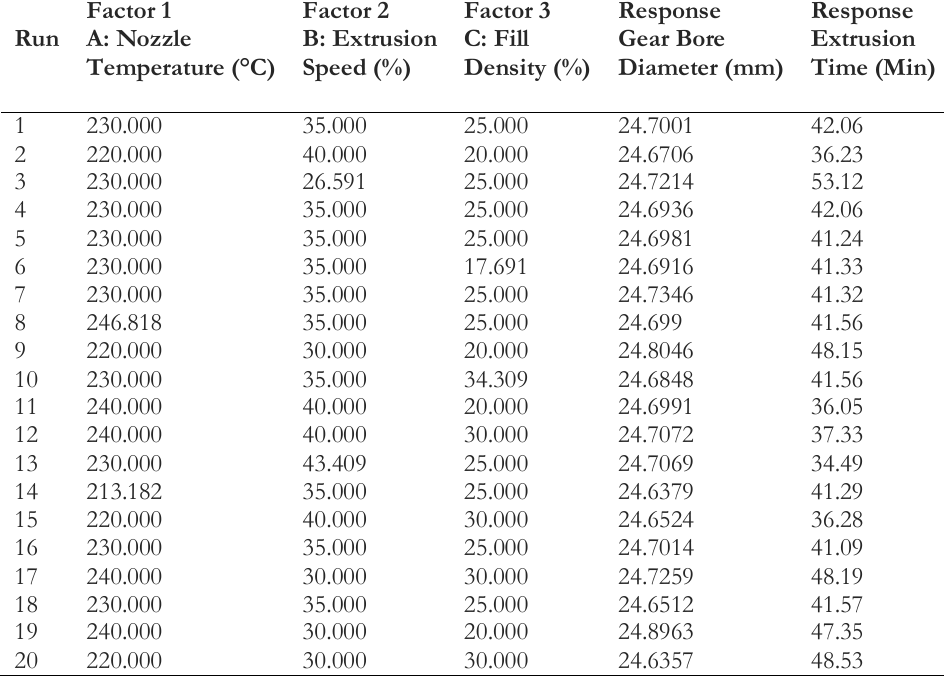
Table 3. Experimental data for input process parameters and response variable.